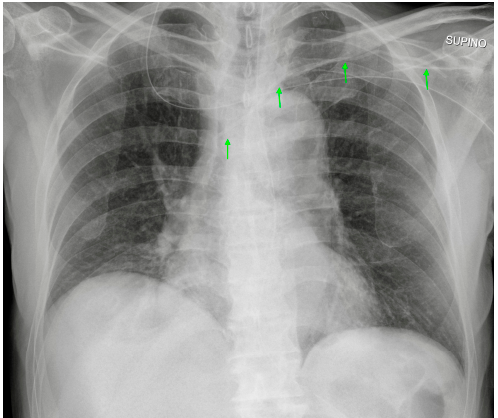
Figure 6. Left-inserted PICC with tip inside the SVC (green arrows).